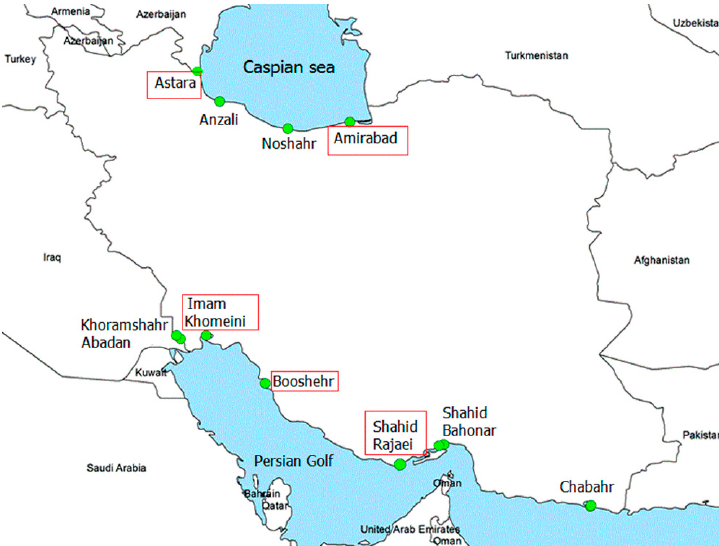
Figure 1. Location of each port on the map of Iran. Table 3. List of alternatives and criteria.